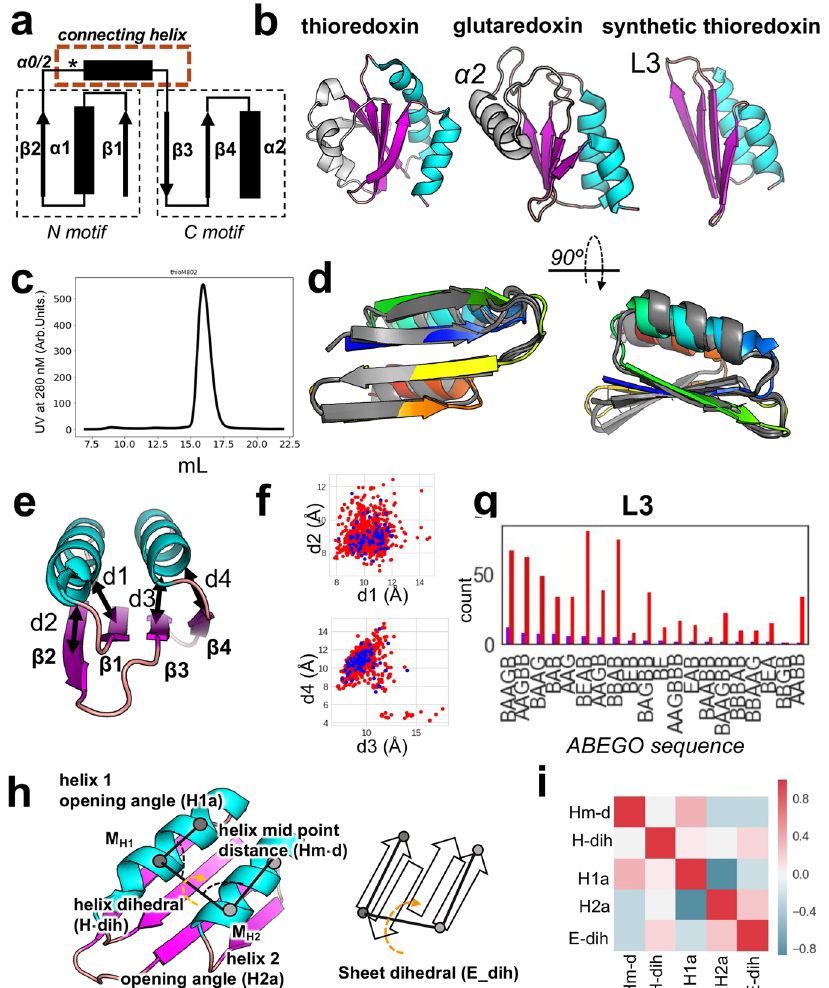
Fig. 4 | Synthetic thioredoxin fold. a Connectivity of the basic thioredoxin fold showingNandCmotifs;theNmotif( βαβ element)representsthestructuralfeature that allows domain extensions. The commonly found α 0, also called α 2, was replaced with the L3 loop for a minimized thioredoxin fold. b Thioredoxin folds found in nature (left and middle) and the designed synthetic thioredoxin (right). c SEC of ThioM_802 shows a single de fi ned peak using a Superdex S75 column. d NMR structure (grey) ensemble (PDB 7LDF) compared to the model (rainbow coloring from N-terminus (blue) to C-terminus (red) of Thio_802. The His-tag was omitted. e Distances in Å, measured between secondary structure elements. f Correlation of distances in stable (blue) and unstable (red) designs. g Several